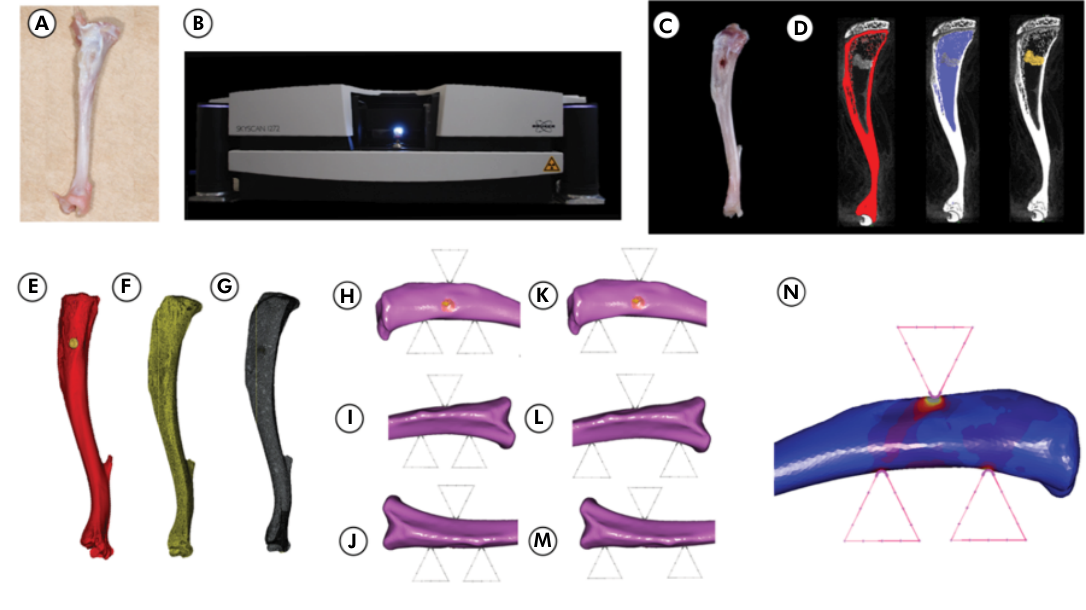
Figure 2. Sequence of 3D models creation for simulation of the three-point bending test on the rat tibia for finite elelement analysis, positioning the bone defect downward, frontal or upward in relation to the load application. A. Representative tibia specimen with bone defect; B. High-resolution Micro-CT; C. BMP file format for bone specimen with defect on metaphysis; D. Segmentation of the cortical, cancellous marrow and bone defecttissues; E. 3D model generated by the Mimics software; F. STL format file before optimization of the mesh; G. Mesh optimization using Patran and 3-Matic softwares; Positioning of the load application in relation to the bone defect: H. frontal; I. upward; J. and downward with 6 mm of distance between the supports; K. frontal; L. upward; M. and downward with 10 mm of distance between the supports; N. Finite element analysis post-processing image of the three-point bending test test with 50 N loading.